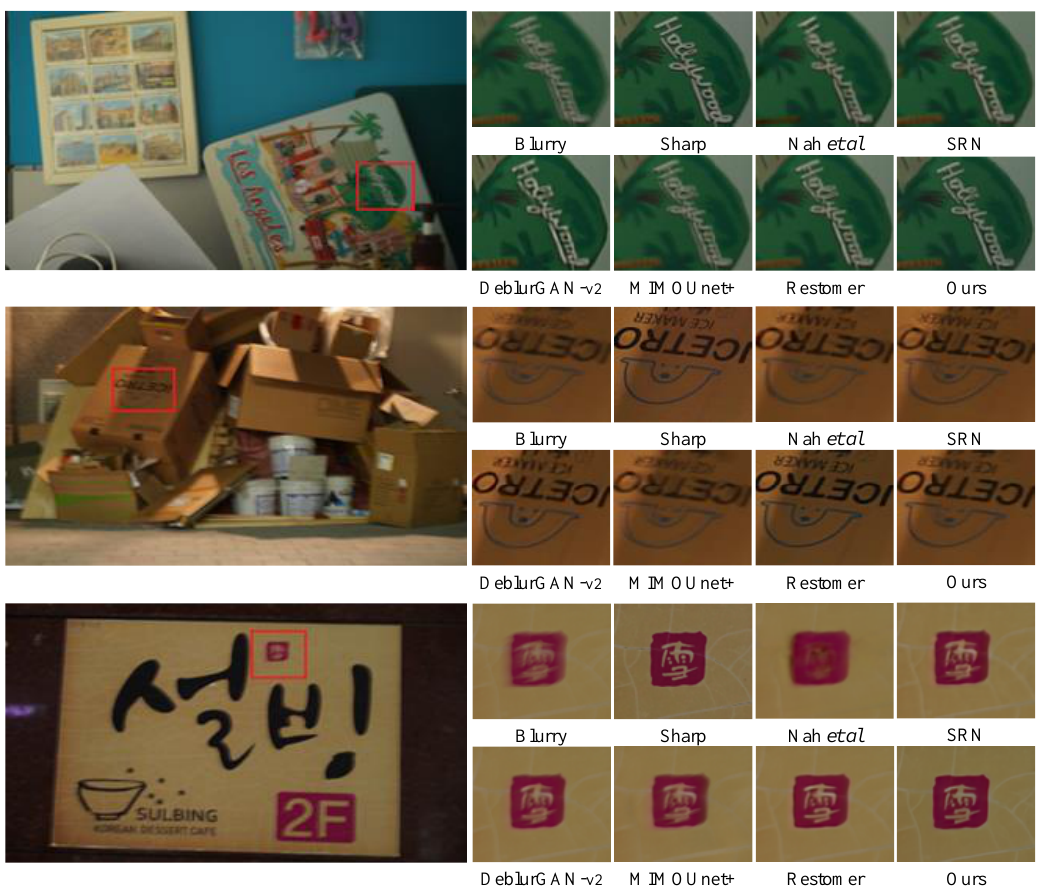
Figure 8. Some visual comparisons on the RealBlur dataset, our models only trained on the GoPro dataset. From top left to bottom right: blurry images, the ground-truth images, the restoration of Nah et al. [7], SRN [12], DeblurGAN-v2 [10], MIMO-Unet+ [8], Restomer [18], and our model. Table 2. Ablation experiment on GoPro dataset [7]. TB indicates the transformer block. The PSNR √ and SSIM are average results per image. The ‘ ’ means that the block is selected for